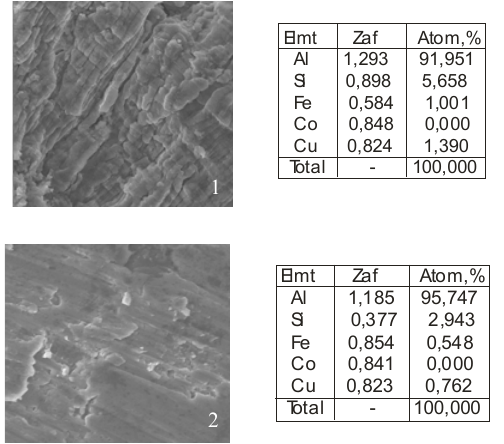
Fig 6. 1- inside friction fragment; 2- outside friction fragment ( ·